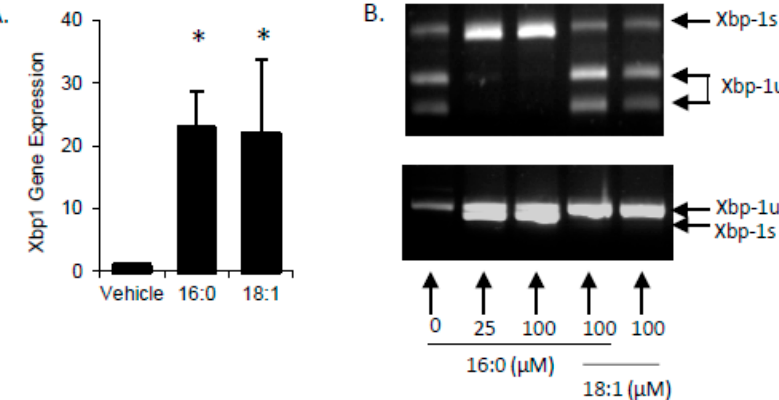
Figure 2. SFA but not MUFA increases Xbp1 splicing. ( A ) Accumulation of FFA have been shown to activate the unfolded protein response with specific induction of Xbp1s. Both SFA (16:0) and MUFA (18:1) increased Xbp1 gene expression after treatment for 2-h. ( B ) Xbp1 exists as either inactive, unspliced (Xbp1u), active, spliced (Xbp1s), or a combination of the two. Xbp1 staus can be examined by resistance to (Xbp1u) or digestion with Pst I (Xbp1s) or by size (Xbp1u is 26 nucleotides longer than Xbp1s). Cells treated with 25- or 100 µ M 16:0 displayed all Xbp1 mRNA as Xbp1s and 18:1 treated cells, either with or without 16:0 showed a marked reduction in Xbp1s content. Data are represented as mean ± SEM; * p < 0.05 vs.